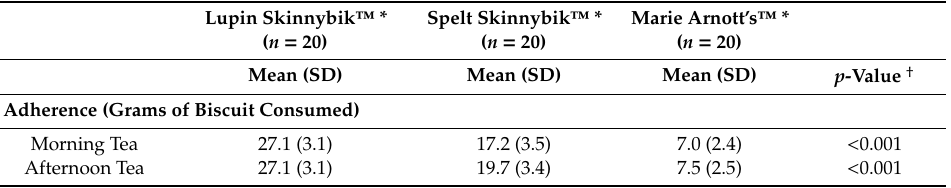
Table 4. Di ff erences in the adherence of study participants to treatment (i.e., grams of biscuits consumed in mid-meals) and the total amount of carbohydrates consumed per main or mid